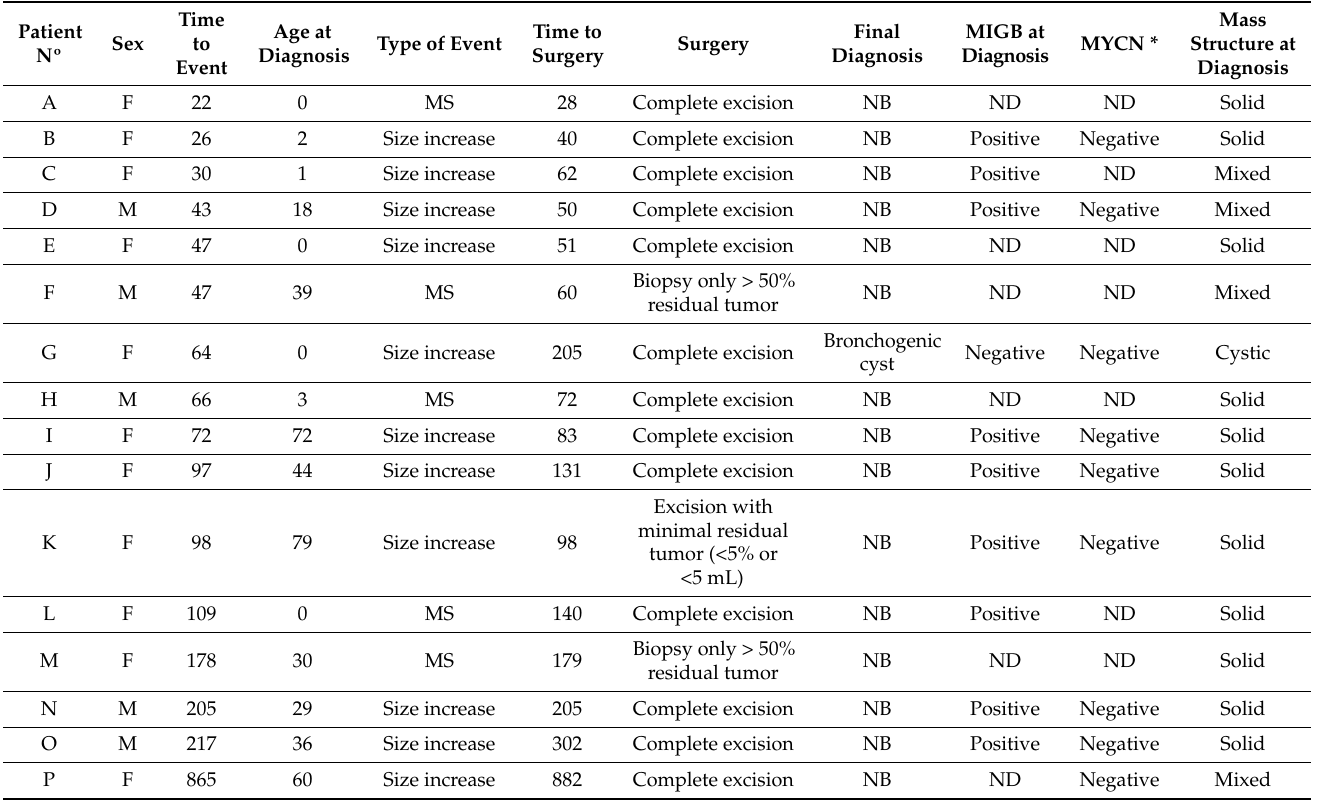
F: female; M: male; Size increase indicates an increase in tumor volume 40%; ND indicates not done; * MYCN amplification status analyzed in plasma at diagnosis, MYCN: cell free DNA analysis for MYCN amplification in plasma. All times are in